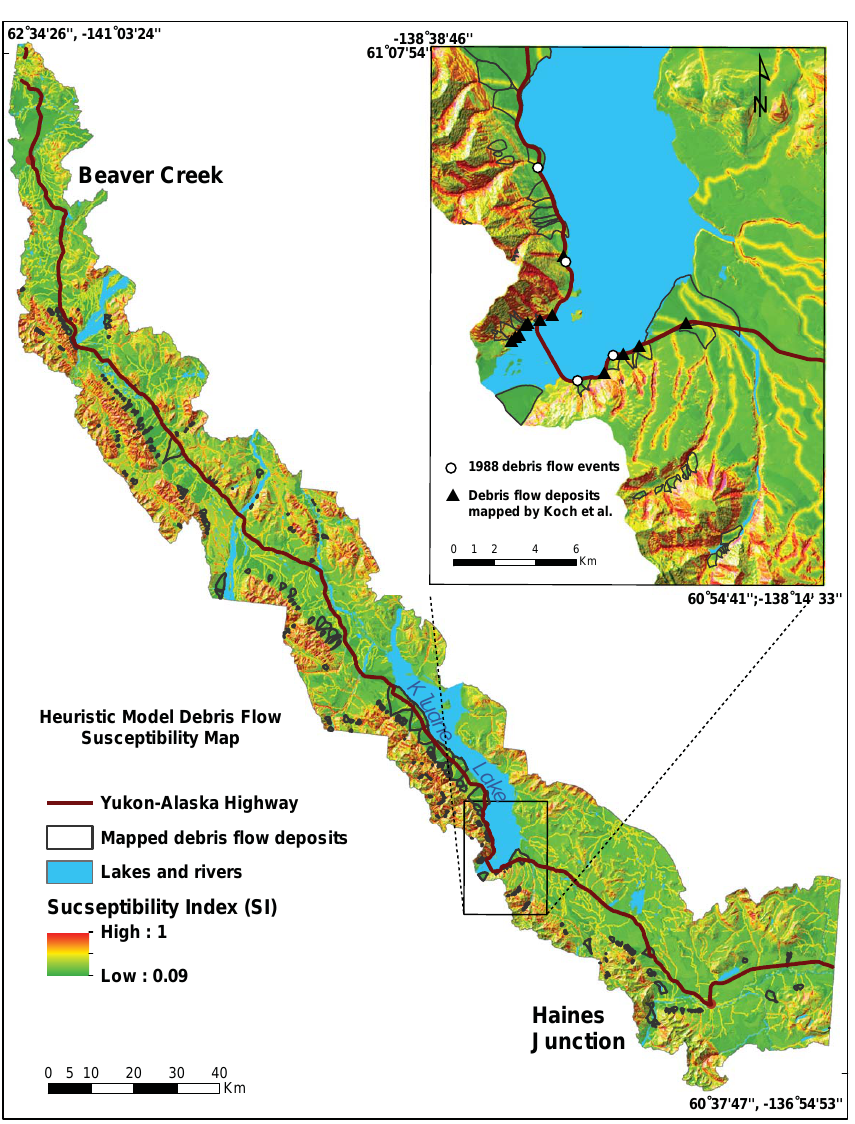
Figure 2. Debris flow susceptibility map created using the qualitative heuristic method for the northern part of YAHC (Fig. 1b). Inset map shows the southern end of the Kluane Lake area (Fig.